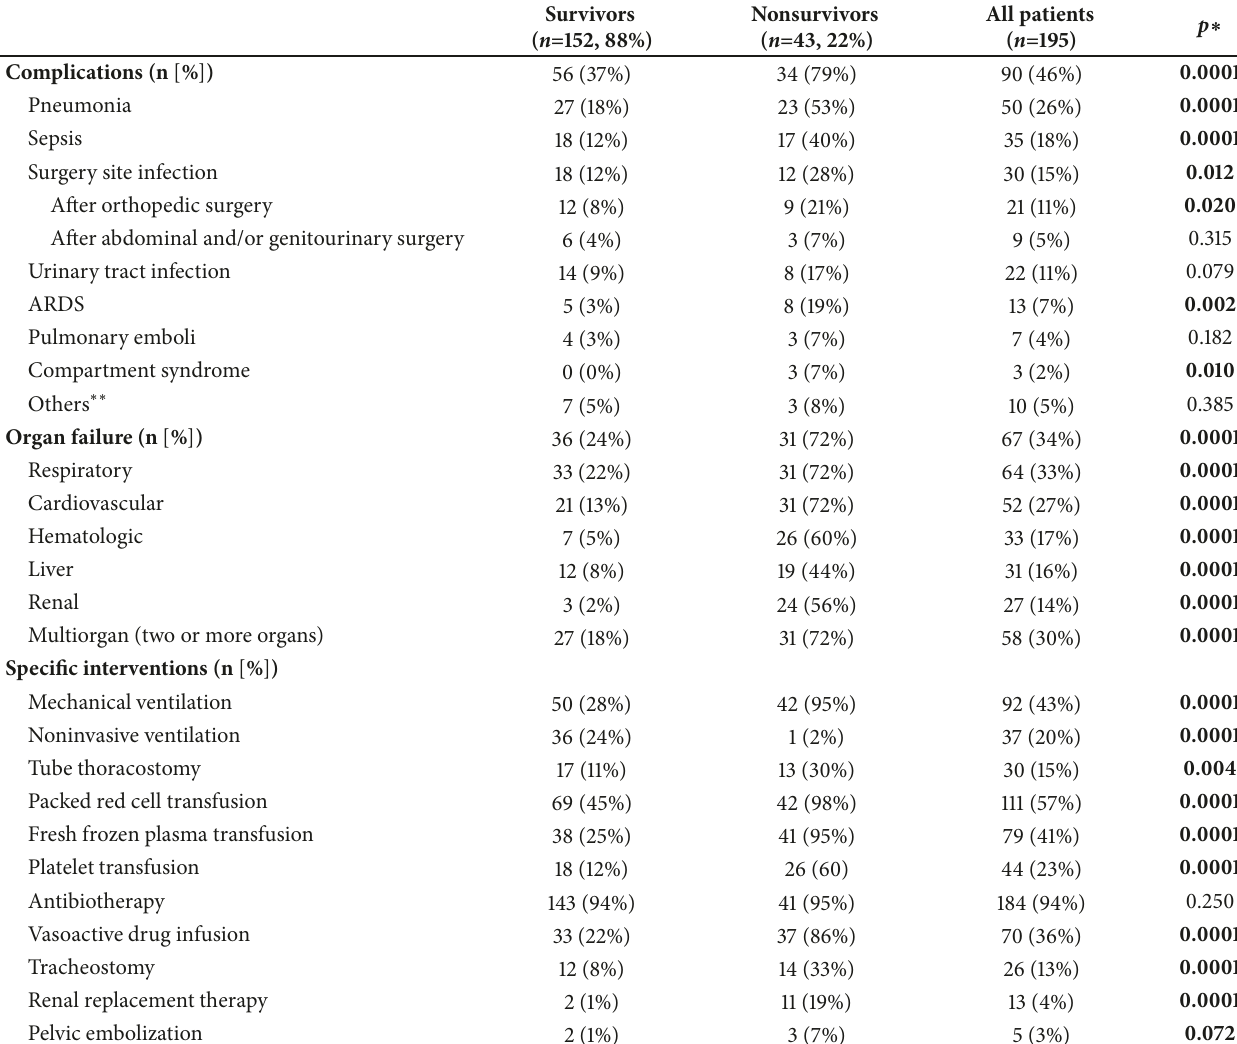
Table 5: Complications, organ failure, and specific interventions during ED admission and